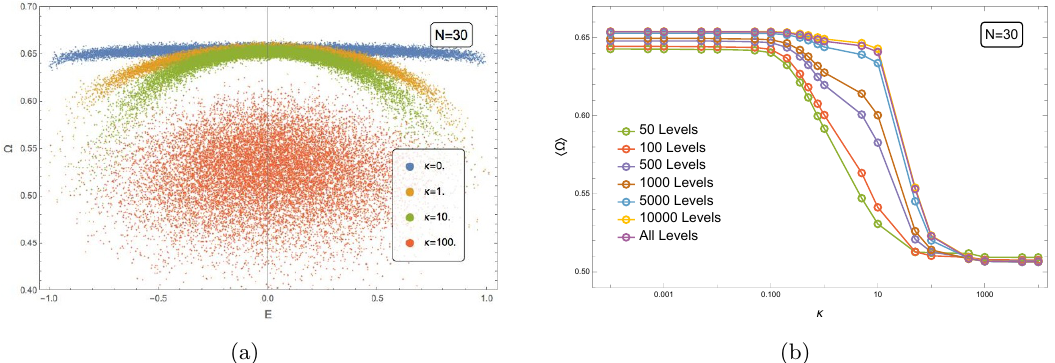
Figure 12 . Left: the distributions of the IR diversity of the even parity sector ( D = 2 14 ) of N = 30 SYK model with (cid:20) = 0 ; 1 ; 10 and 100 versus normalized energy E , respectively. Right: the mean value of the IR diversity of the subsectors of the spectra including L levels starting from the ground state of the even parity sector ( D = 2 14 ) of N = 30 SYK model versus (cid:20)